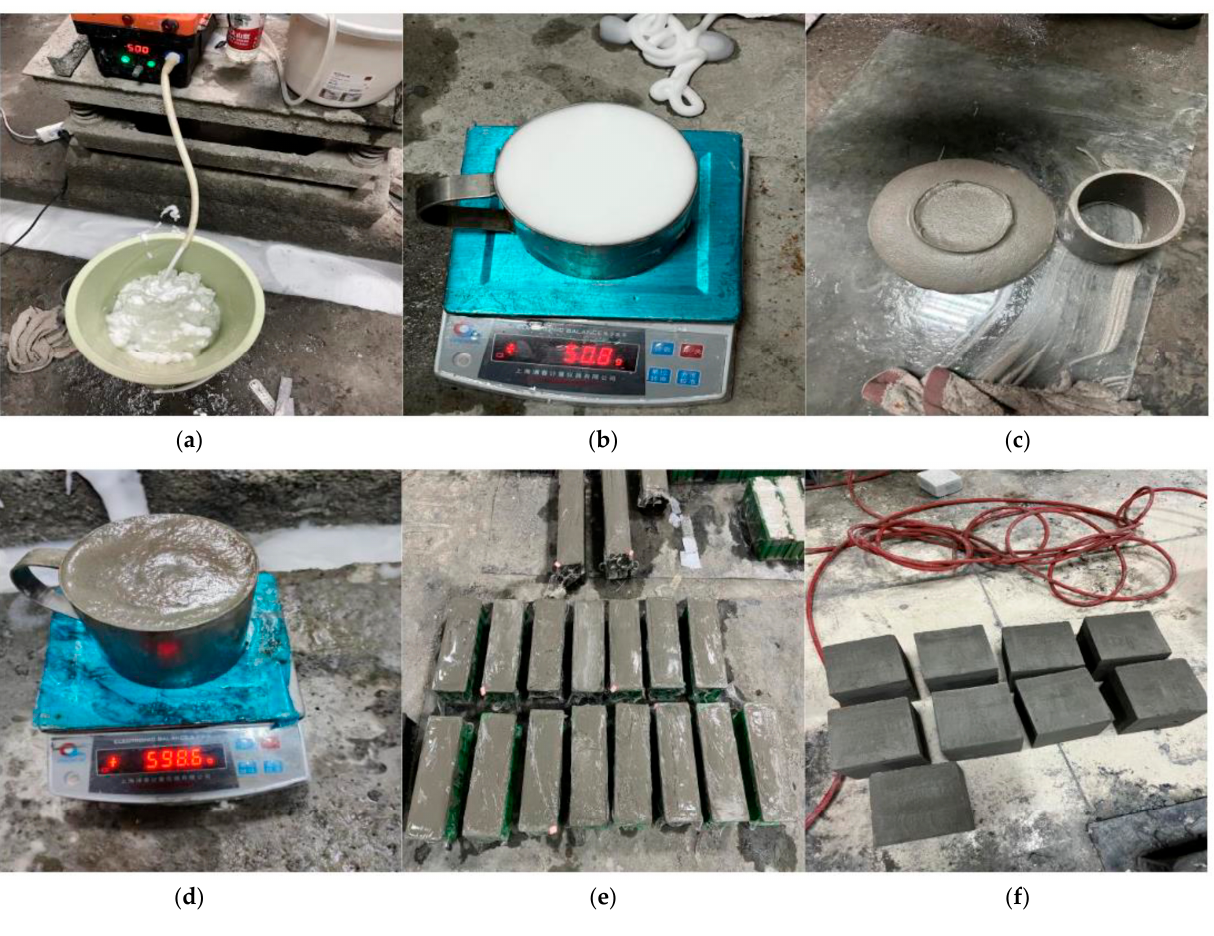
Figure 1. Production process of LCFLS: ( a , b ) foam preparation; ( c , d ) measurement of flowability and wet density; ( e , f ) molding and curing.